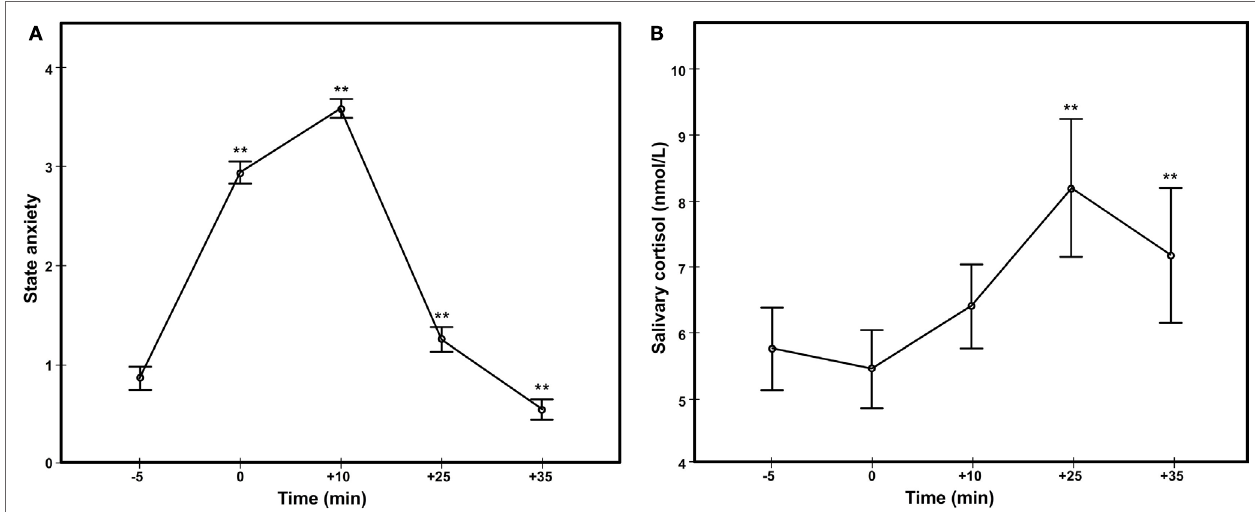
FigUre 2 | anxiety responses in the Trier social stress Test, based on likert self-reported state anxiety (a) and salivary cortisol